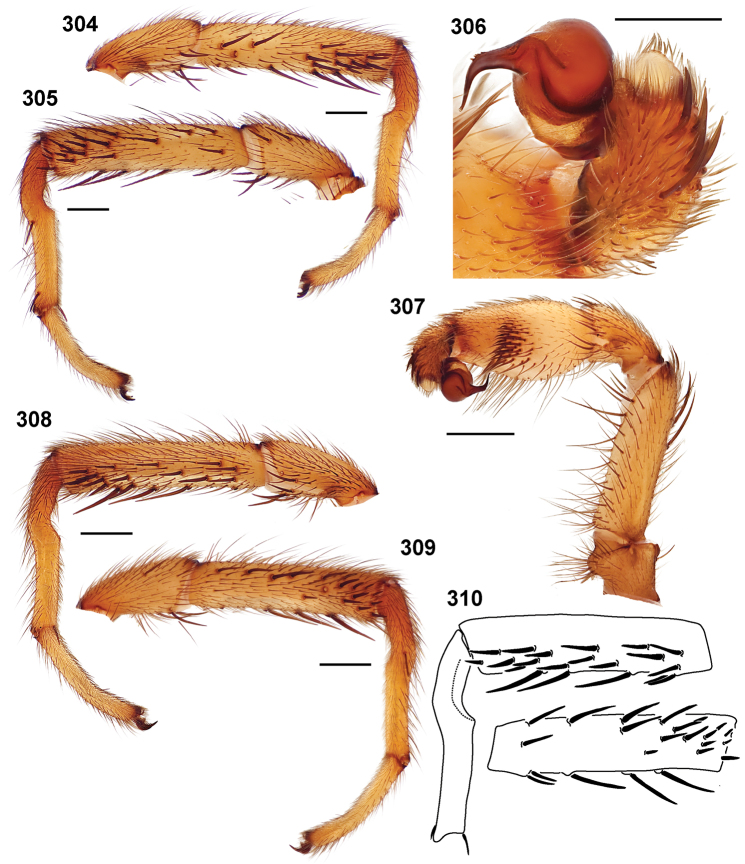
Aptostichus lucerne sp. n. from San Bernardino County. 304–307 male holotype (AP434); scale bars = 1.0mm and 0.5mm (306) 304 retrolateral aspect, of right leg, leg I [806479] 305 prolateral aspect, of right leg, leg I [806483] 306 oblique, ventral/retrolateral aspect of palpal bulb [806485] 307 retrolateral aspect, pedipalp [806487] 308, 309 male paratype 308 retrolateral aspect, leg I [806489] 309 prolateral aspect, leg I [806493] 310 line drawings of leg I spination pattern; retrolateral aspect tibia and metatarsus; prolateral aspect of tibia.